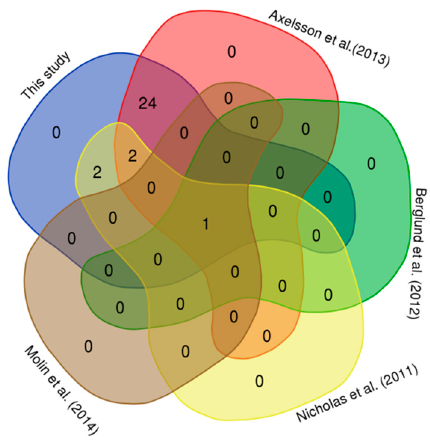
Figure 3. Comparison between identified CNVs in this and other studies.